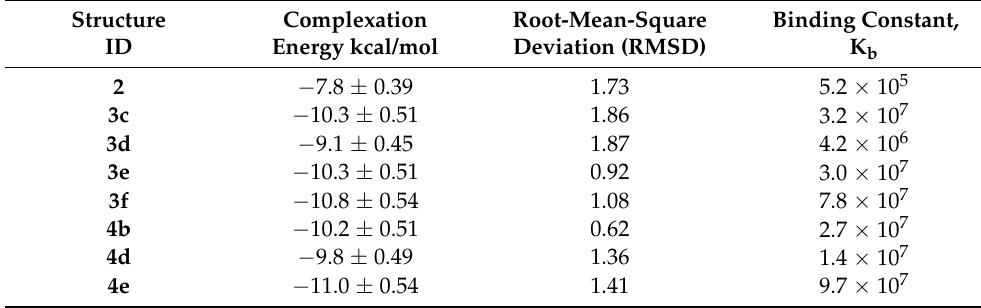
Table 8. Biophysical calculation of complexations of compounds ( 2 , 3c – f , 4b , 4d and 4e ) with